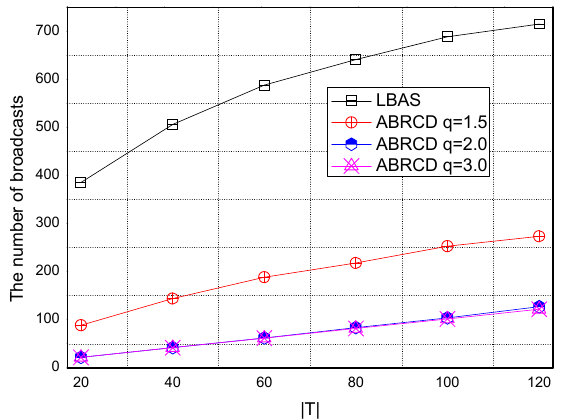
Figure 31. The impact of | T | with fixed network size = 1000 on the number of broadcasts. The impact of network size is shown in Figures 32–37, with fixed | T | = 20, 40, 60, 80, 100, 120, respectively.